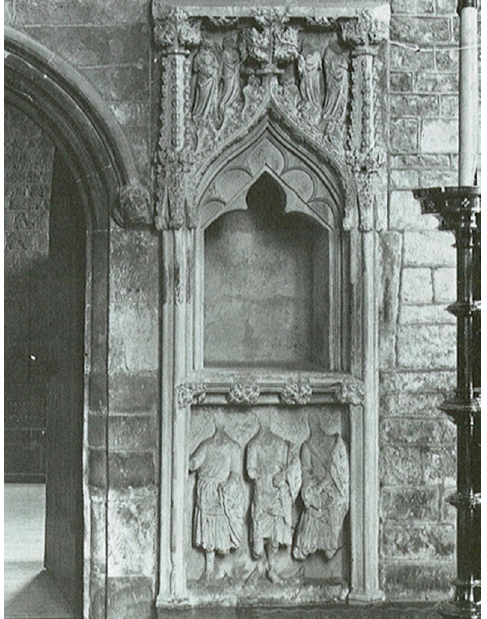
Figure 11. Easter Sepulchre, St. Peter, Navenby, Lincolnshire, England. Early 14th century [Source: Sheingorn, The Easter Sepulchre (1987), Figure 36].